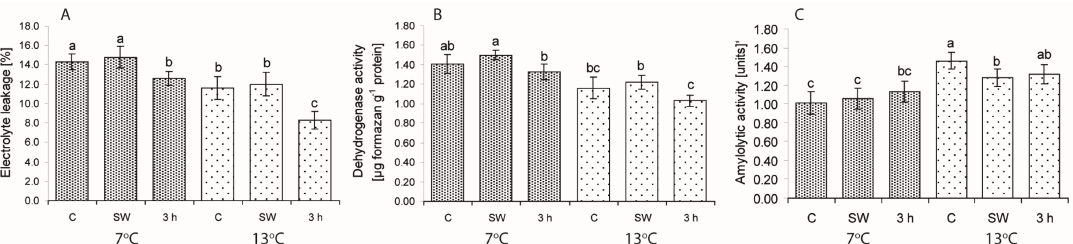
Figure 5. Effect of low (7 ◦ C) and control (13 ◦ C) temperatures and treatments on the percentage of ion leakage ( A ), dehydrogenase ( B ) and amylolytic activity ( C ) in the seeds of lines/cultivars included in Group III (very well germinating). C—control, non-stimulated seeds; SW—smoke water; 3 h—3-h hydropriming. Values represent means ( ± SE) of four lines/cultivars based on five replicates in the case of DA and A, and on 10 replicates in the case of EL for each line/cultivar. Different superscript letters (a, b, c, ...) in the columns indicate significant differences between means (Duncan’s multiple range test; p < 0.05). One unit of amylolytic activity means a decrease in absorbance by 0.02, which released